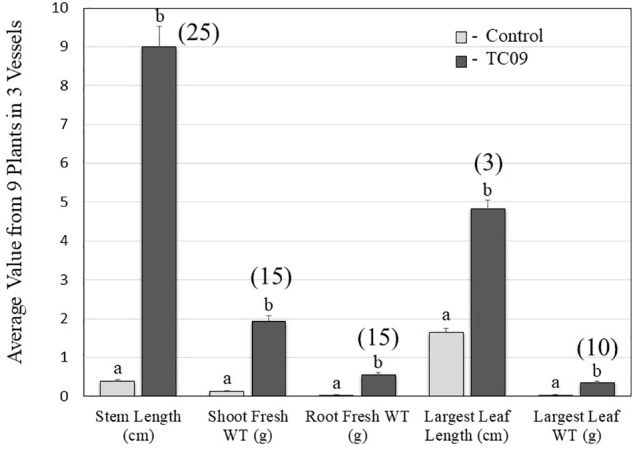
Quantification of five growth parameters of control and TC09-exposed in vitro tobacco plants. Six-day-old tobacco seedlings following seed sowing were exposed to medium-containing closures (control) or fungal culture containing closures for 20 days and then subject to measurement to determine growth status. Values represent means obtained from triplicate vessels for each treatment. Each vessel contains three individual plants. Data in shaded bars from TC09-exposed plants were converted into fold increase over corresponding values from control plants and labeled in parentheses. Standard errors of the means were marked as vertical lines. Paired treatments sharing a letter on top of bars are not significantly different at P > 0.05 based on Tukey’s test.